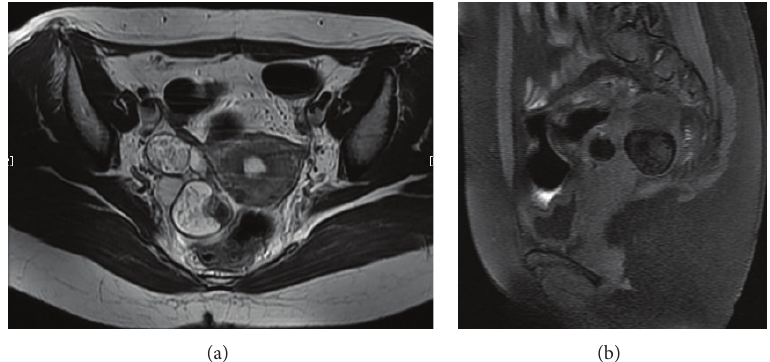
Figure 1: Right ovarian cyst with fat in cystic cavity before second surgery. (a) Axial T2-weighted image shows high-signal intensity cyst. (b) Fat-saturated T1-weighted image shows signal decrease on the cyst.